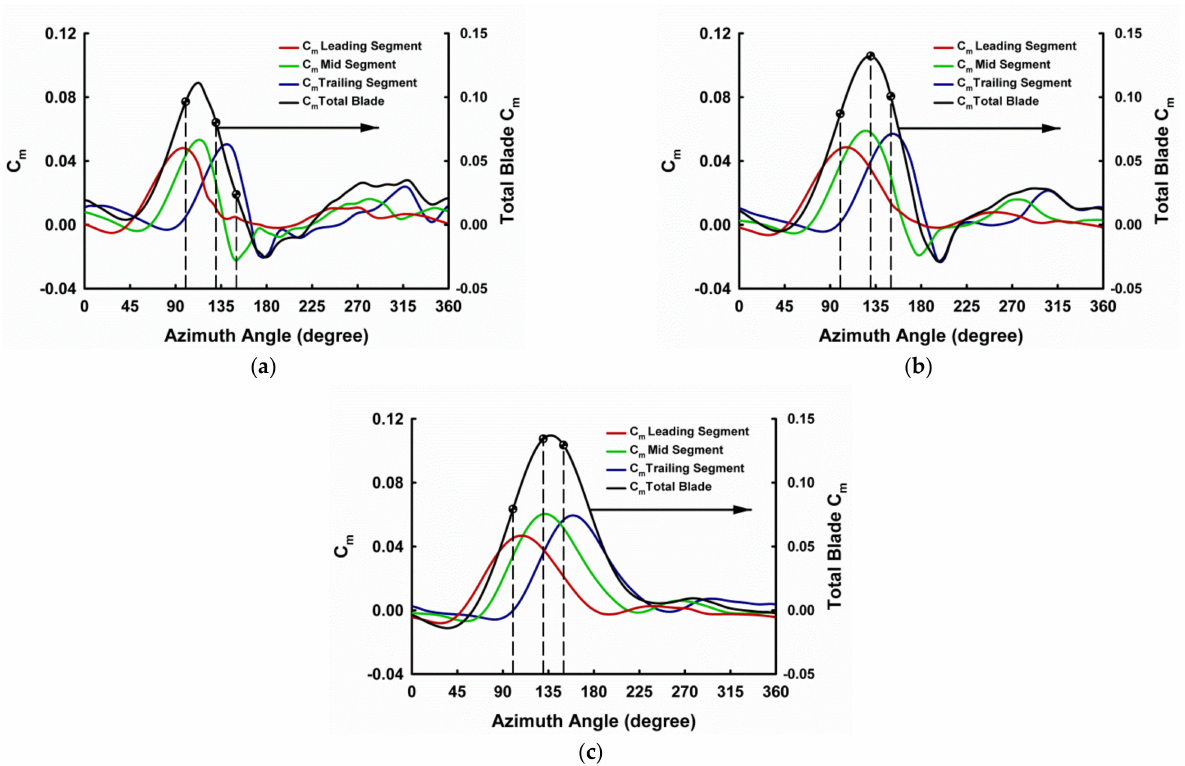
Figure 20. Section-wise C m contribution of different segments of a single blade of a 90 ◦ helical VAWT operating at TSRs of ( a ) 2.7, ( b ) 3.1, and ( c )